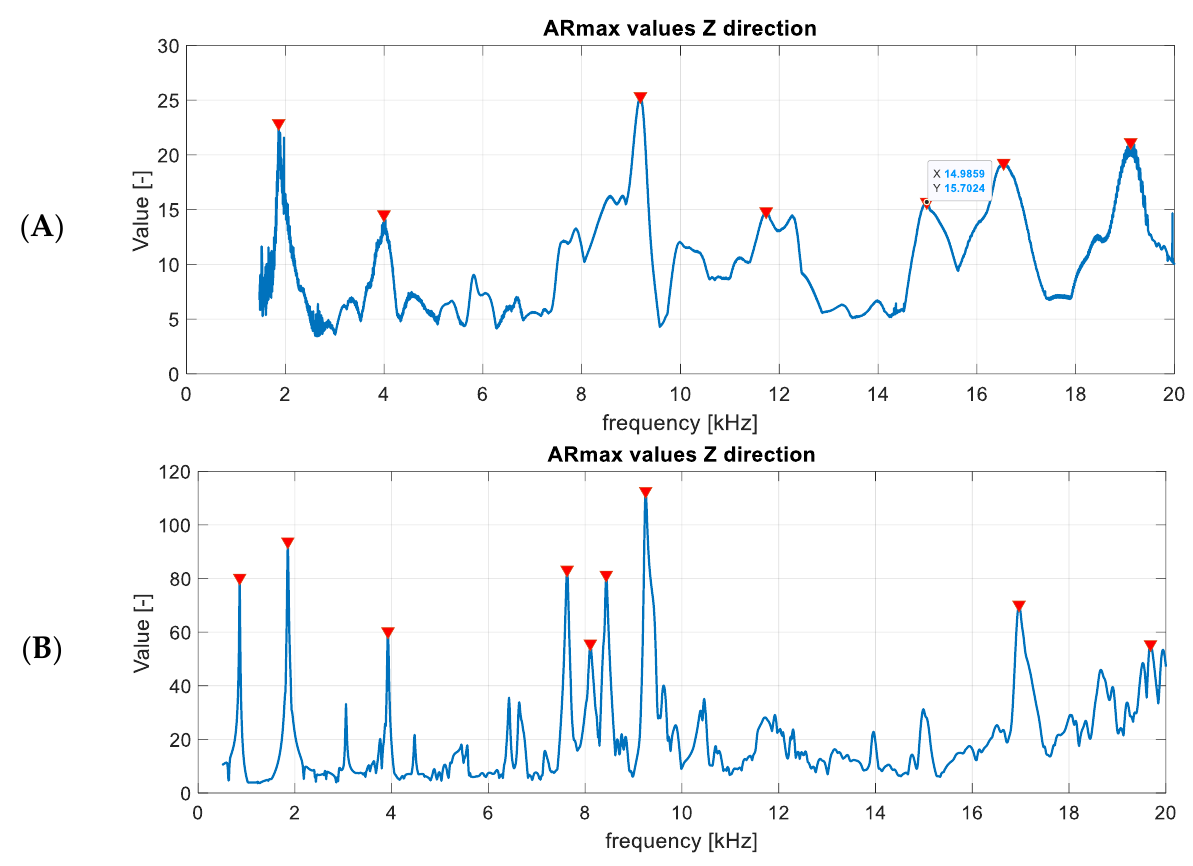
Figure 8. Computed ARmax characteristics and LDR frequencies selected by the algorithm for experimental data ( A ) and the numerical results ( B ).